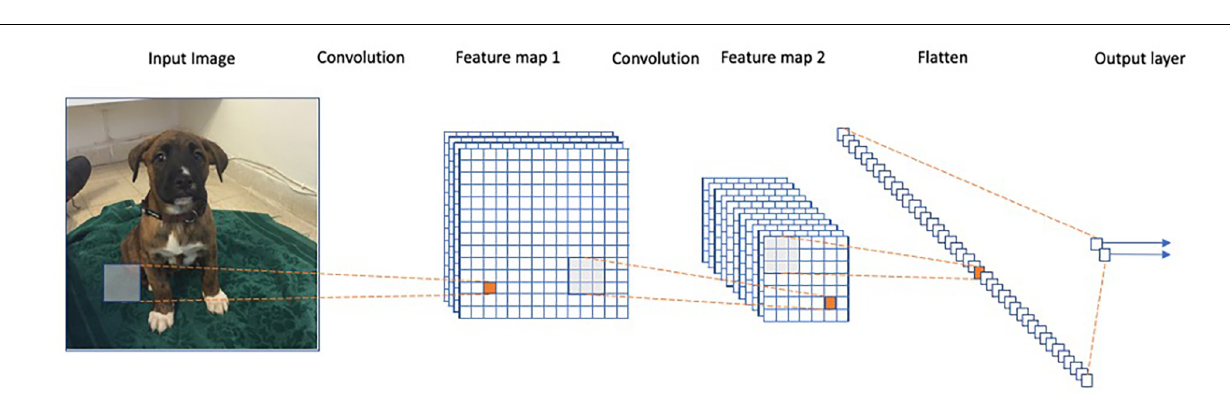
FIGURE 2 | Representation of a convolutional neural network. Each convolution operation consists of applying the same filters across the image to obtain a feature map in the following layer. The final iteration produces a fully connected layer similar to a regular neural